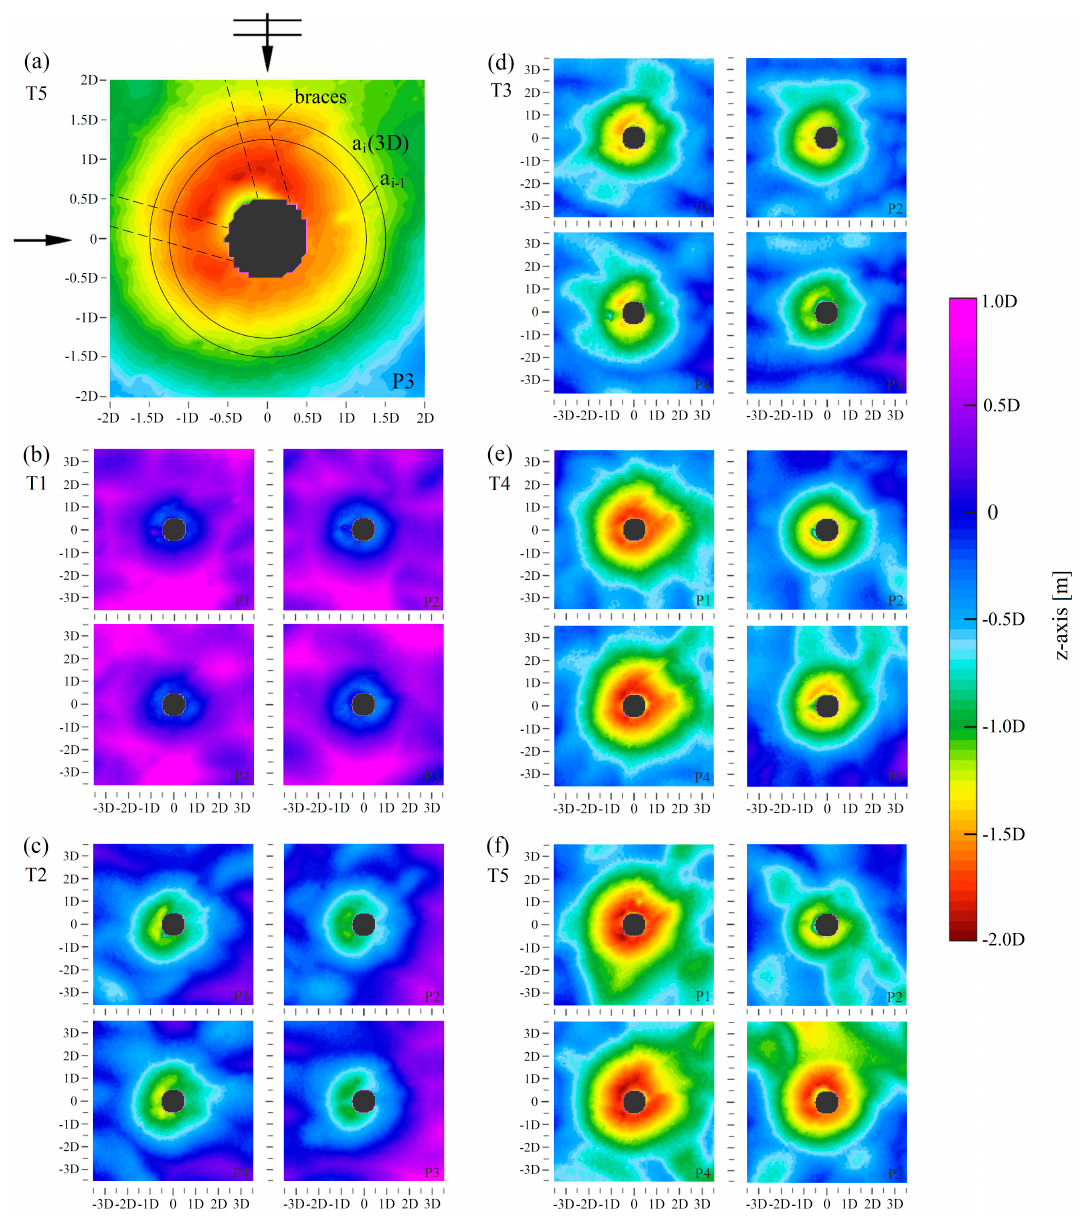
Figure 13. ( a ) Local bed topography, illustrated as an example for test 5, pile 3 with a sketch of the diagonal braces, including the direction of the incoming current, which is coming from left to right, waves are perpendicular to the current as well as exemplary circles related to an incremental interrogation area of 3 D and the directions of the diagonal braces; ( b–f ) local bed topography related to test 1–5; ( b–f ) in an area of 7 D around each main pile of the jacket structure.